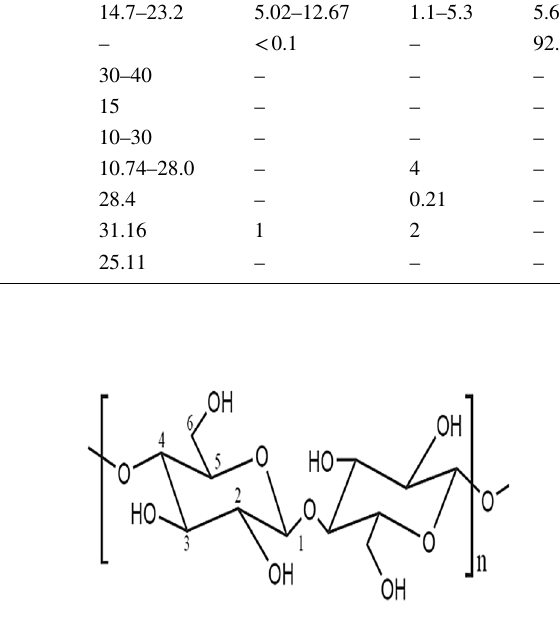
Fig. 1 Molecular structure of cellulose